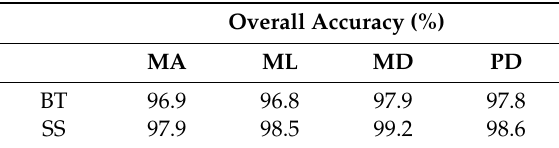
Table 1. Overall accuracy of automated algorithms, Blue Thresholding (BT) and Spectral Similarity (SS), versus supervised classifiers: the Mahalanobis distance (MA); the Maximum Likelihood (ML); the Minimum Distance (MD); and the Parallelepiped classifier (PD).